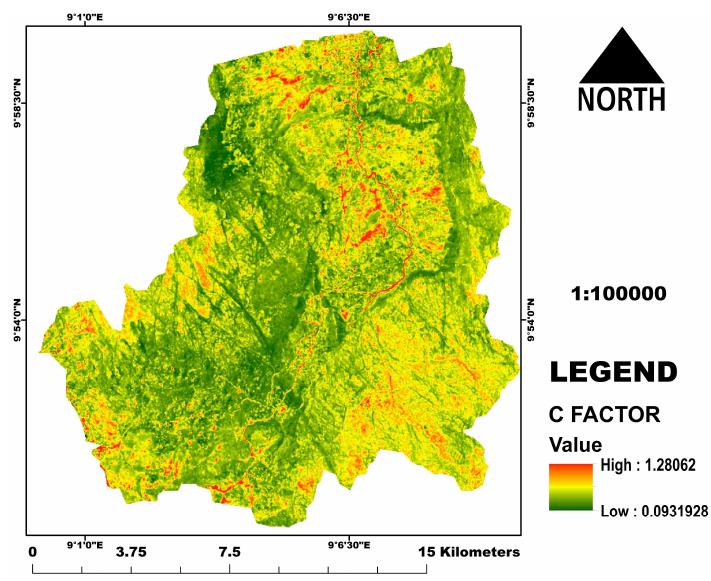
Figure 11. The C factor map.